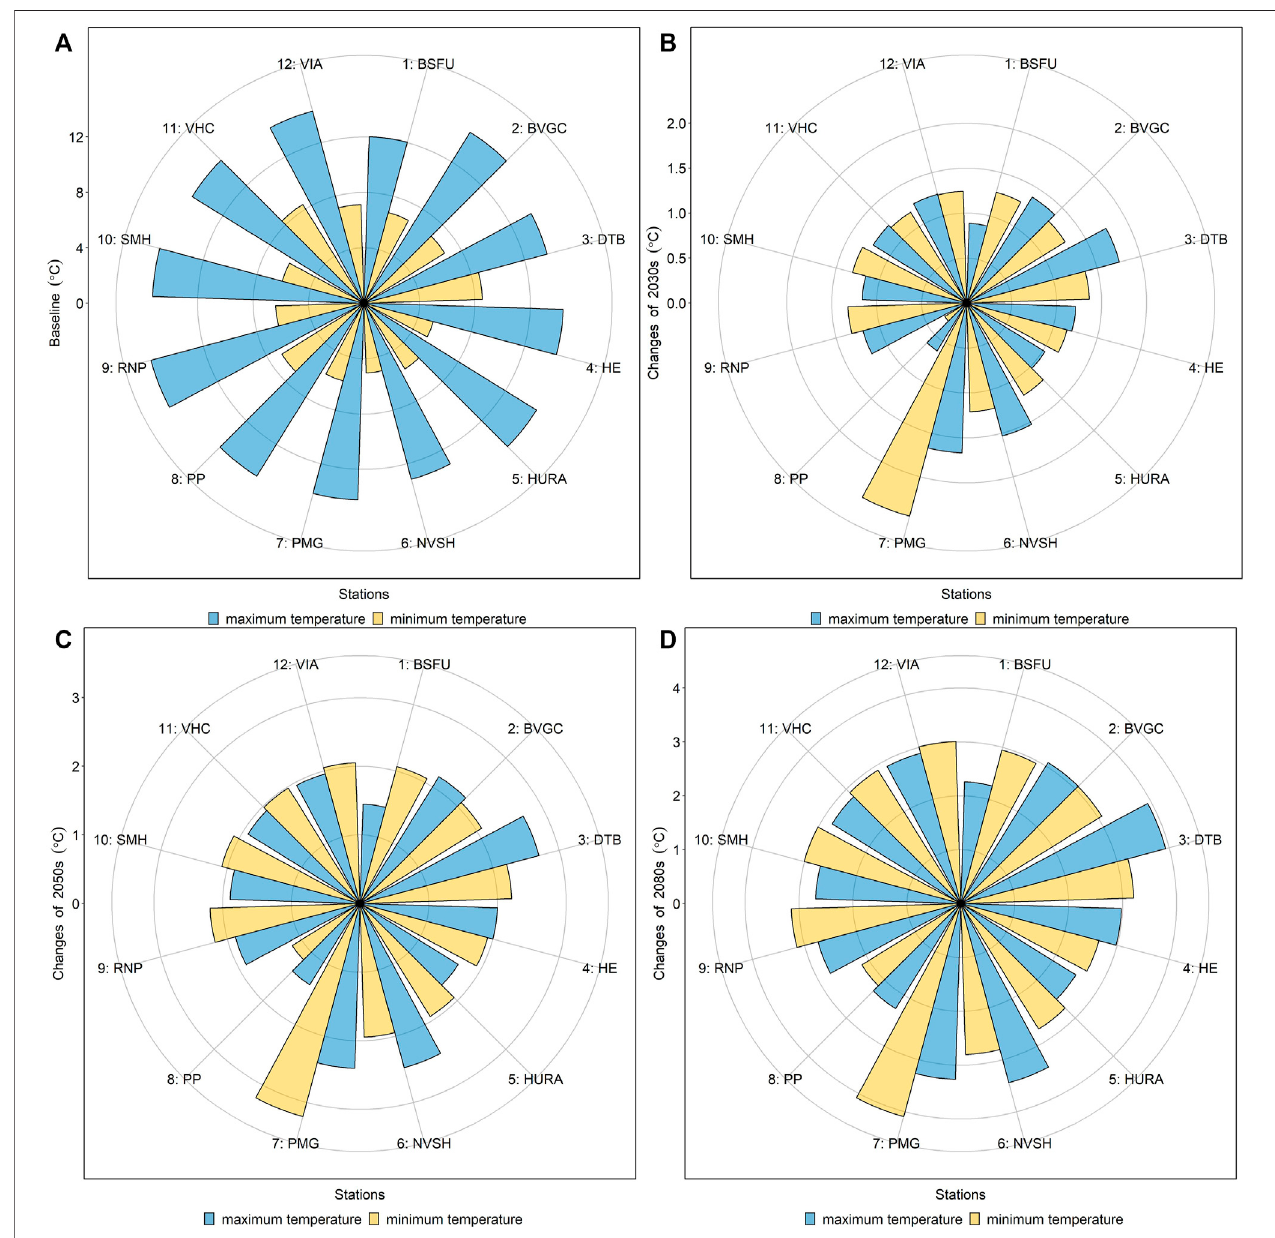
FIGURE 9 | Baseline temperature (A) and projected changes over 2030s (B) , 2050s (C) , and 2080s (D)